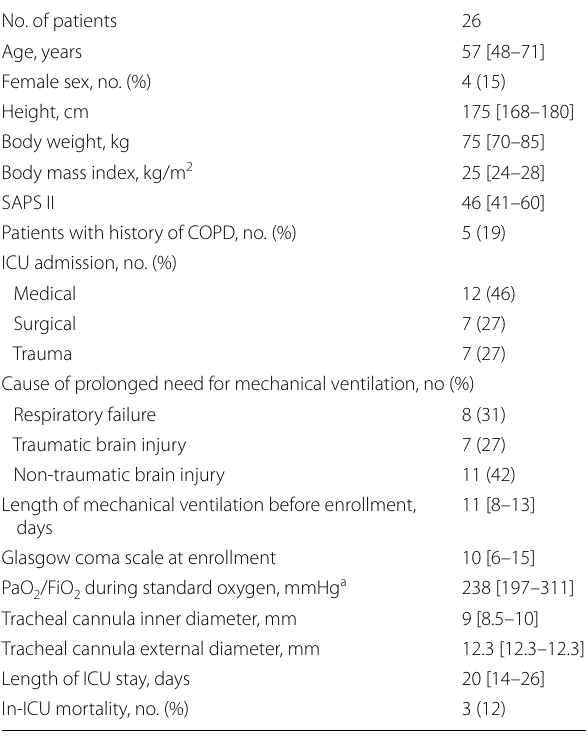
Table 1 Baseline characteristics of enrolled patients